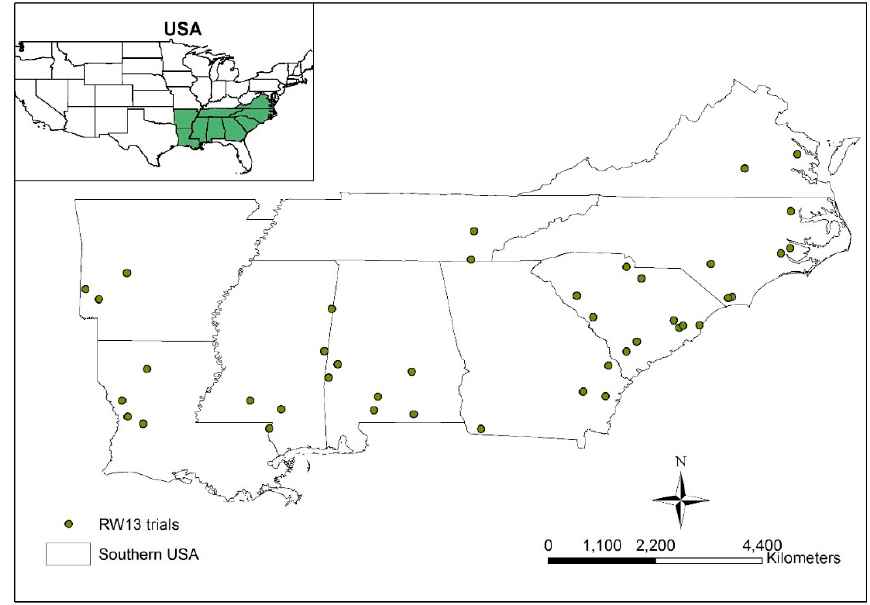
Figure 1. Distribution of Regionwide 13 (RW13) sites in the southeastern United States (SEUS). Table 1. RW13 fertilization treatments.